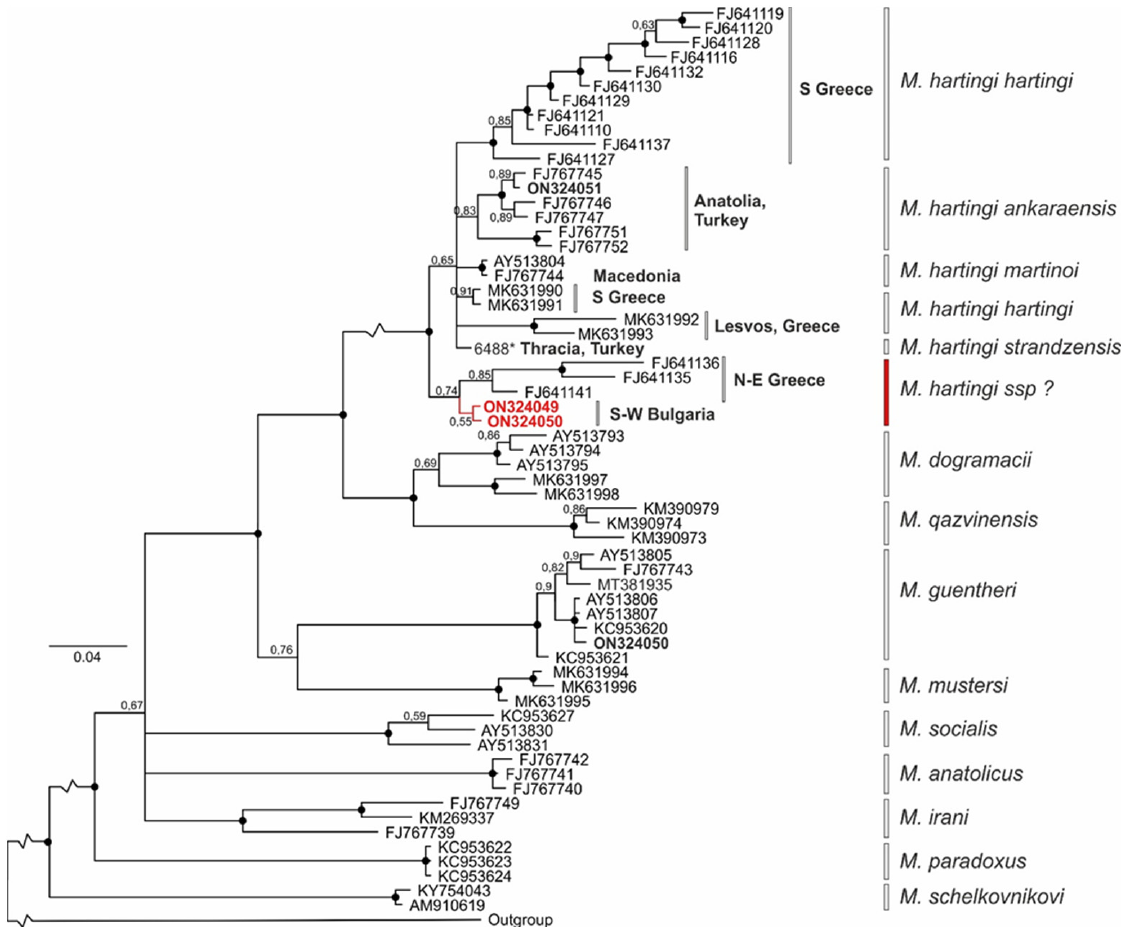
Figure 7. The BI tree built using a Cytb fragment. Node values denote Bayesian posterior probabilities. Black circles indicate nodes with support above 0.95.